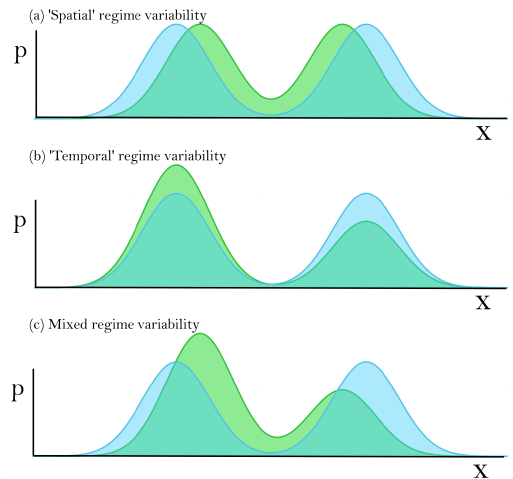
Figure 1. A schematic showing different kinds of regime variabil- ity, illustrated with a bimodal, 1D probability distribution, the two peaks of which could be considered as regimes. (a) Spatial variabil- ity: the position of the two regime centroids is different between the two distributions, but their frequency of occurrence is unchanged. (b) Temporal variability: the two regime centroids are located in the same position on the x axis in both distributions, but the oc- currence frequencies are different. (c) Mixed variability: here the regimes differ both temporally and spatially between the two dis- tributions, showing shifts in the positions of the regimes and their occurrence frequencies. In this case there is no unambiguous way to relate the regimes of one distribution to those of the